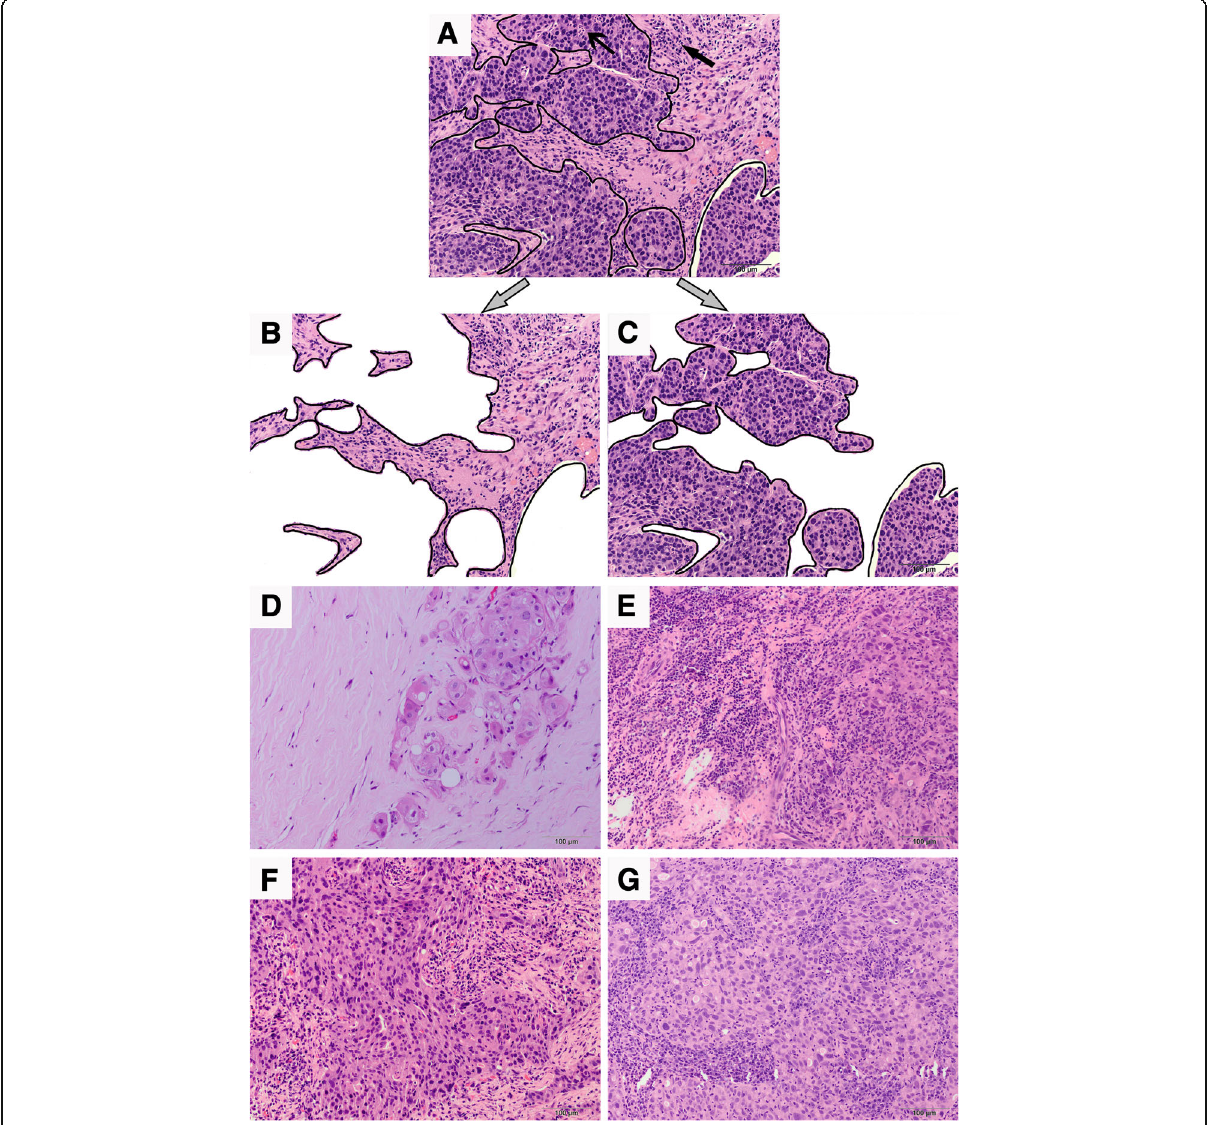
Fig. 1 Histopathologic evaluation of TILs and different scores of TILs in TNBCs. a : The areas of sTILs and iTILs evaluation were distinguished by black lines (bold black arrow pointed to plasma cells and lymphocytes, Fine black arrow pointed to polymorphonuclear leukocytes which should be excluded in TILs evaluation). b : The area of sTILs evaluation: 20%; c : The area of iTILs evaluation: 0%. d : sTILs: 0%. e : sTILs: 50%. f : iTILs: 10%. g : iTILs: 20% (All × 200